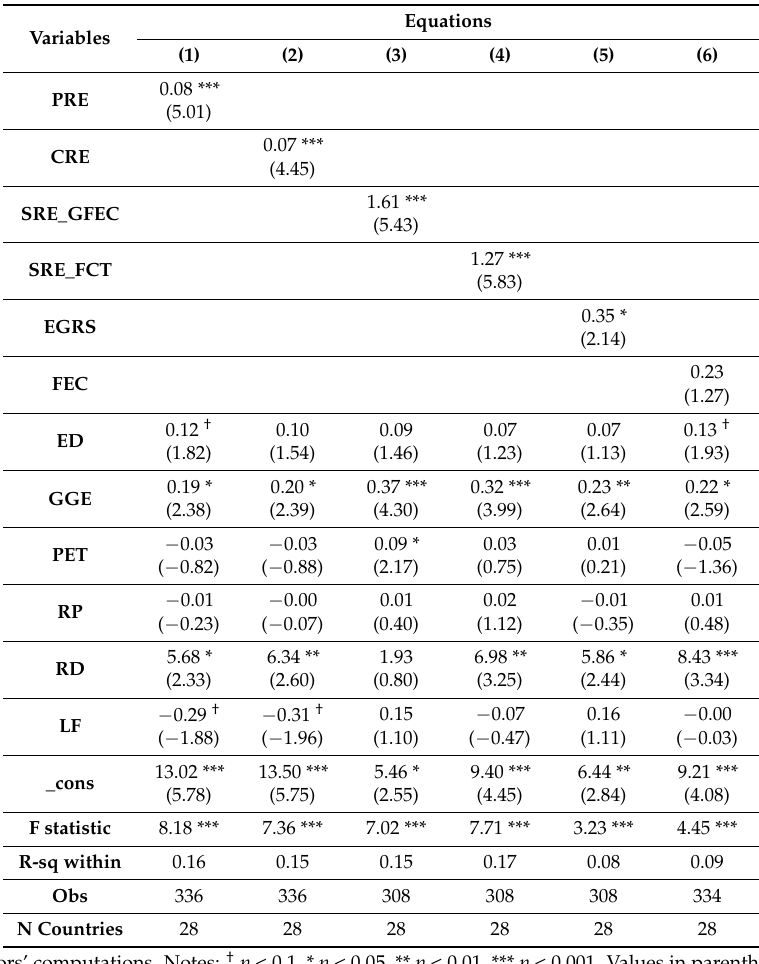
Table 6. Fixed-effects estimations towards the impact of renewable energy (overall) on sustainable economic